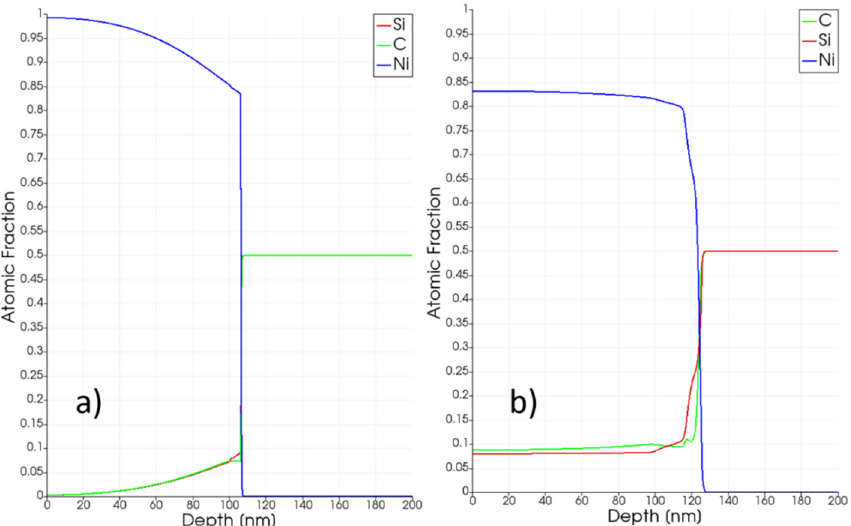
Figure 2. Total atomic fraction as a function of the position of the three elements of the Ni-Si-C ternary system (Ni blue line, Si red line, C green line) after 100 ns (panel ( a )) and at the end (panel ( b )) of the simulated irradiation at E dens = 2.2 J/cm 2 energy